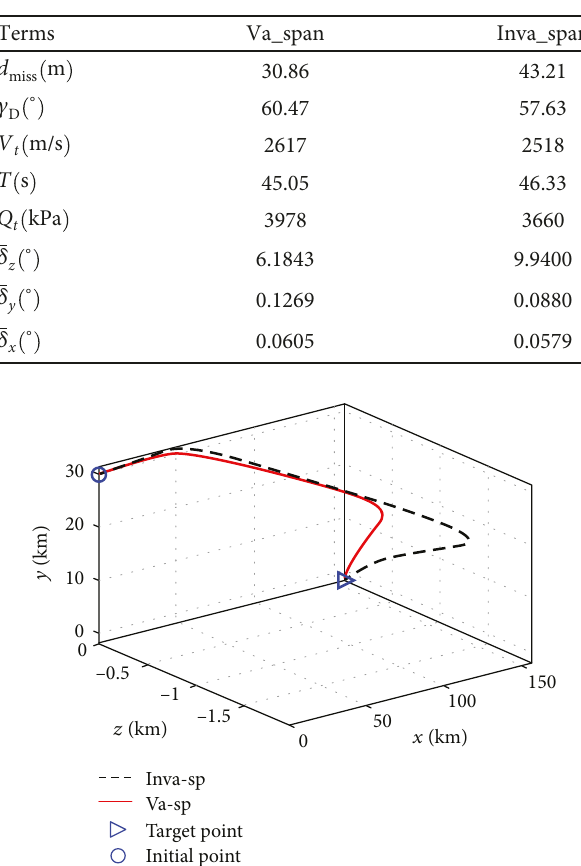
Table 5: Results of the adaptive dynamic surface IGC method.